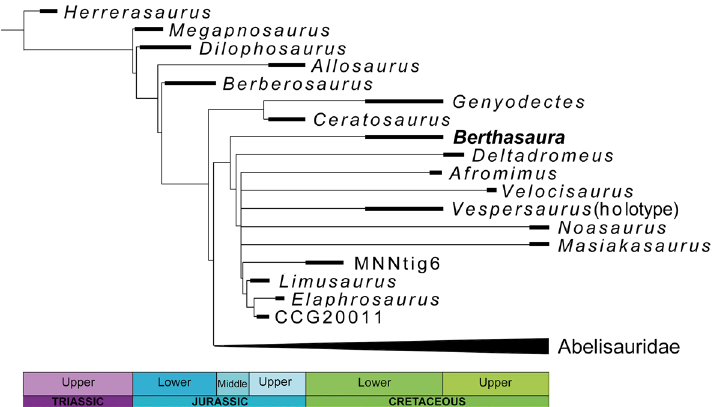
Figure 6. Phylogenetic relationship of Berthasaura leopoldinae gen. et sp. nov . , holotype (MN 7821-V). Time- calibrated reduced strict consensus trees of the 448 equally minimum-length trees with 454 steps